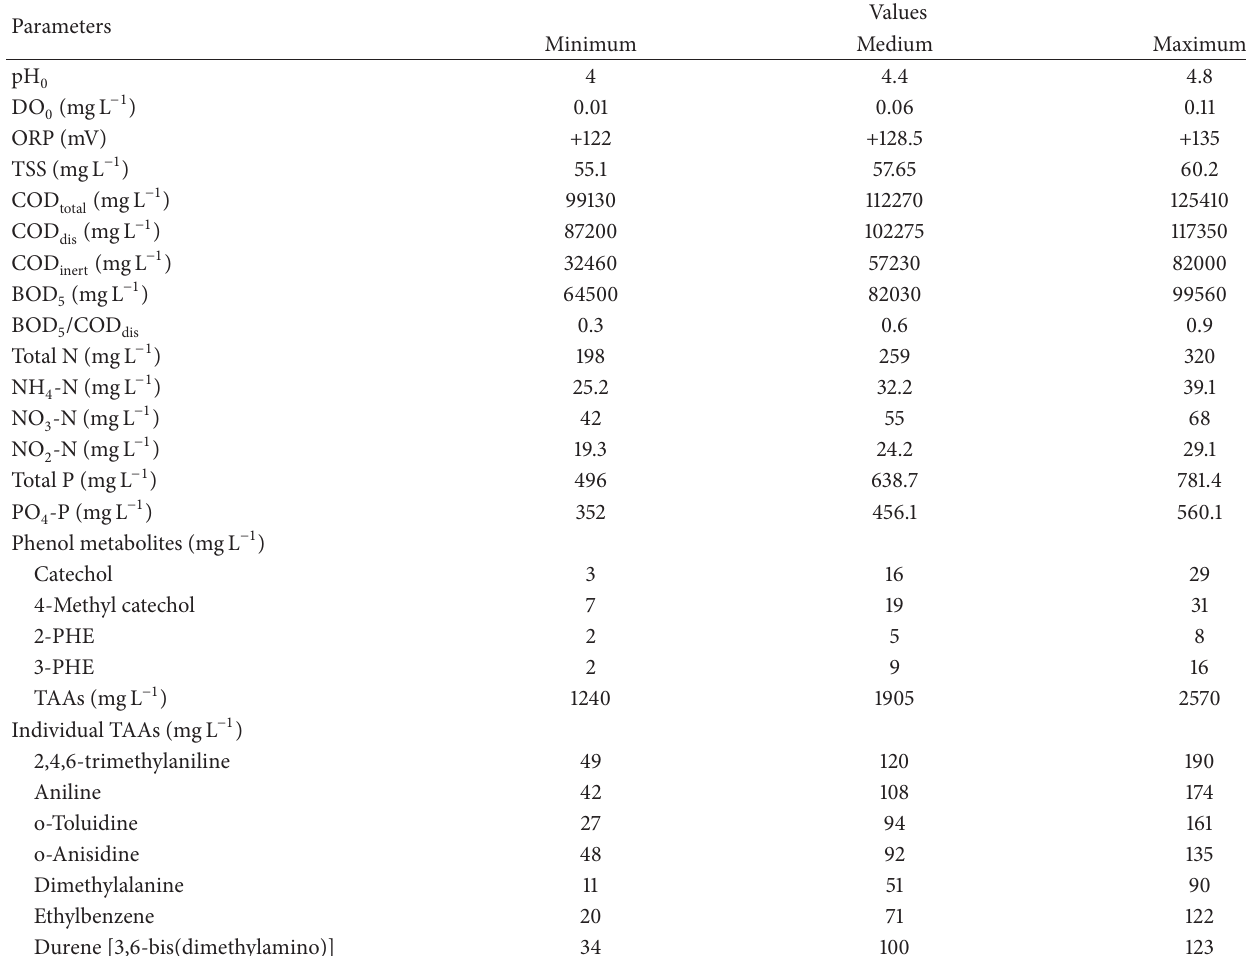
Table 1: Characterization values of OMW at pH = 4.5 ( 𝑛 = 3 , mean